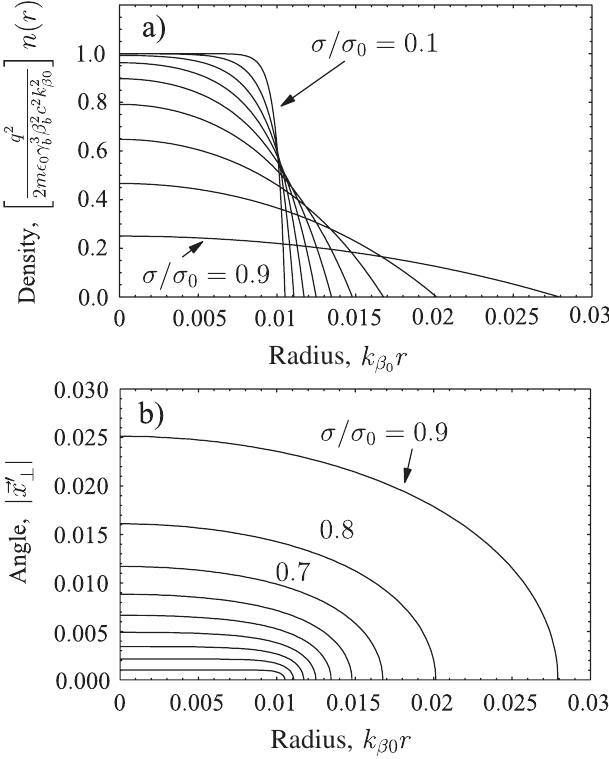
FIG. 12. Waterbag equilibrium distribution in continuous- focusing channel for fixed focusing-field strength ( k 2 const ) and perveance Q ¼ 10 (cid:1) 4 with (rms-equivalent beam measure) relative space-charge strengths (cid:3)=(cid:3) 0 : 1 . In (a) the scaled density profile ½ q 2 = ð 2 m(cid:7) is plotted versus the dimensionless radial coordinate k (b) the distribution edge ( f ? ¼ 0 curve) in x ? - x 0 plotted as a function of k spond to the dimensionless equilibrium parameters in Table